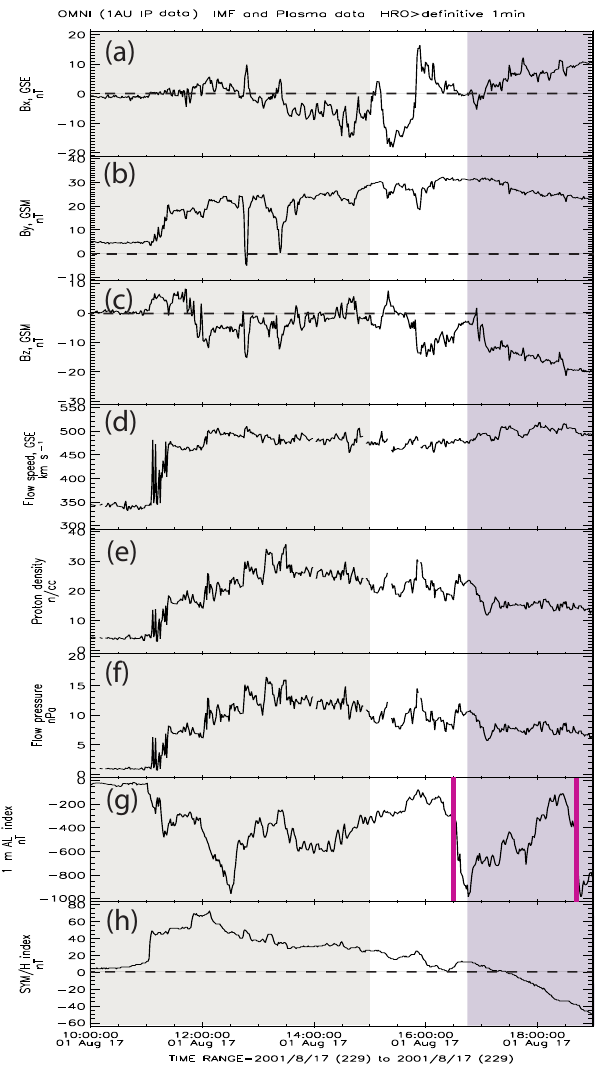
Figure 2. Solar wind (GSE coordinates), IMF (GSM coordinates) and geomagnetic indices during the passage of the CME on 17 Au- gust 2001. (a) IMF B X , (b) IMF B Y , (c) IMF B Z , (d) solar wind bulk speed, (e) proton density, (f) flow pressure, (g) AL index where the two vertical red lines are the times of two substorm onsets, and (h) SYM-H index. The time period marked with light grey (10:00 to 15:00UT) is when Polar and IMAGE were both viewing the same (northern) hemisphere, while the darker grey period from 16:45UT to 19:00UT is when the two satellites provided simultaneous im- ages from the conjugate